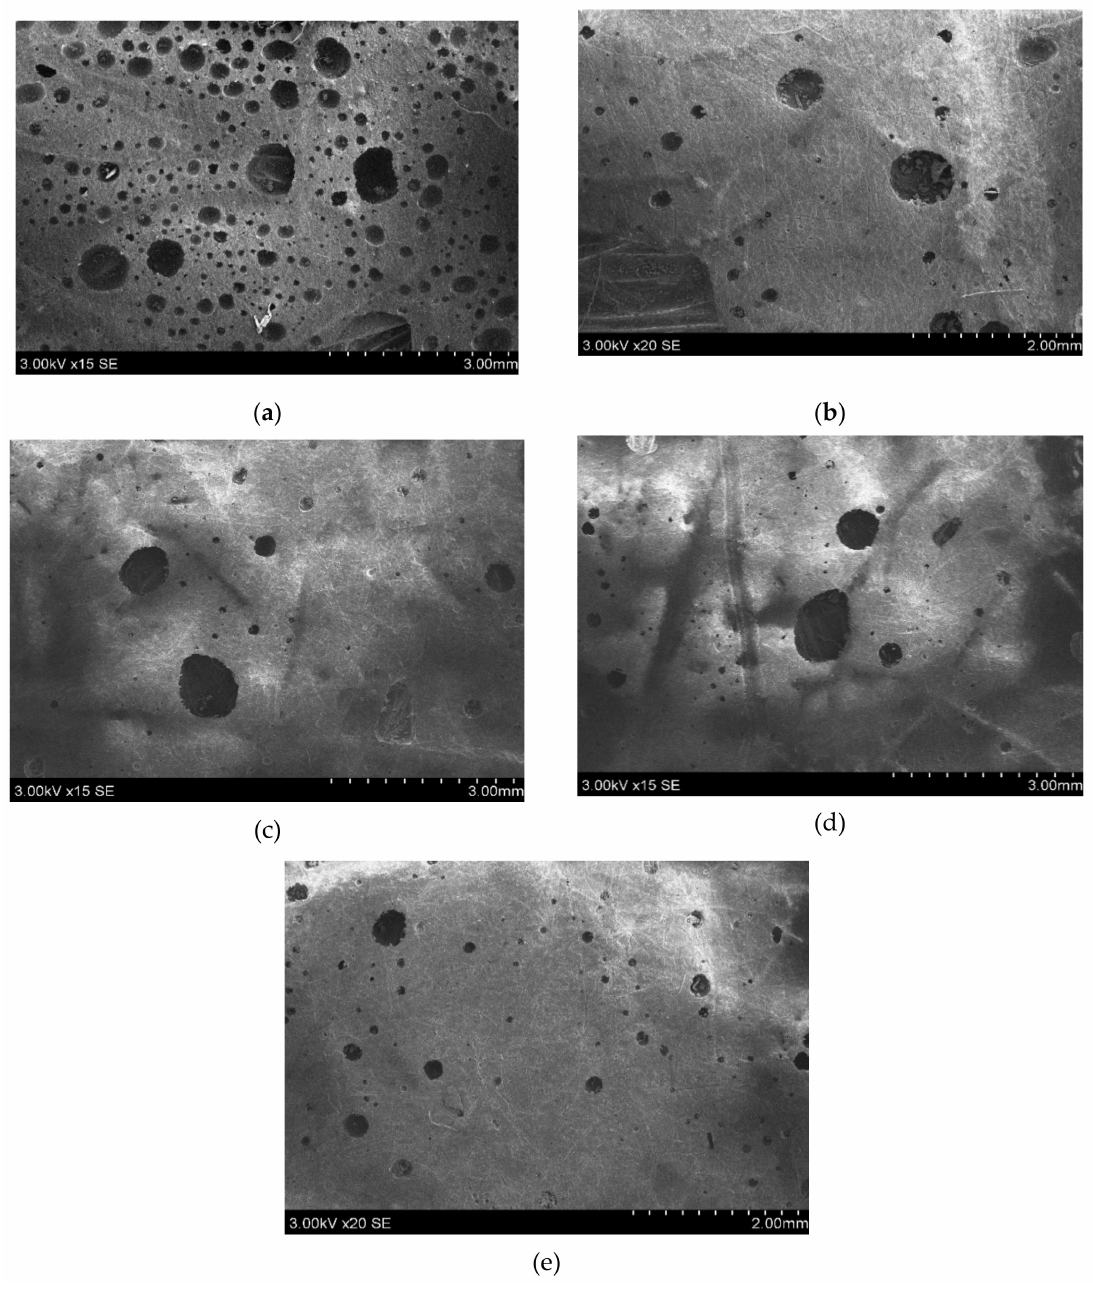
Figure 17. SEM images for porosity (void content) presented in the fabricated composites ( a ) 0C/40S, ( b ) 15C/25S, ( c ) 20C/20S, ( d ) 25C/15S, ( e )